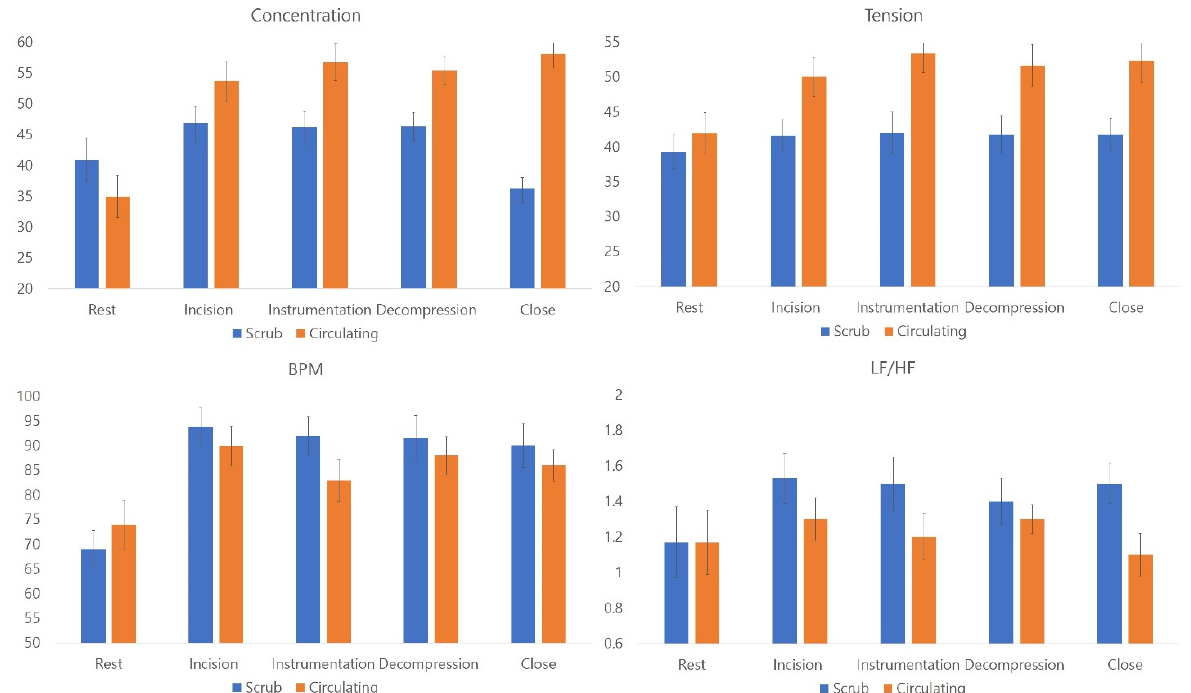
Figure 2. Comparison of stress-related parameters between scrub nurses and circulating nurses. The levels of concentration and tension, BPM, and LF/HF ratio levels of nurses during all surgical stages. All parameters were significantly different between scrub and circulat- ing nurses ( p < 0.05, Student’s t -test) (Unit: percentage). The levels of concentration and tension were significantly higher in circulating nurses than in scrub nurses. However, BPM values and the LF/HF ratio, which reflect physical stresses, were higher in scrub nurses than in circulating nurses.